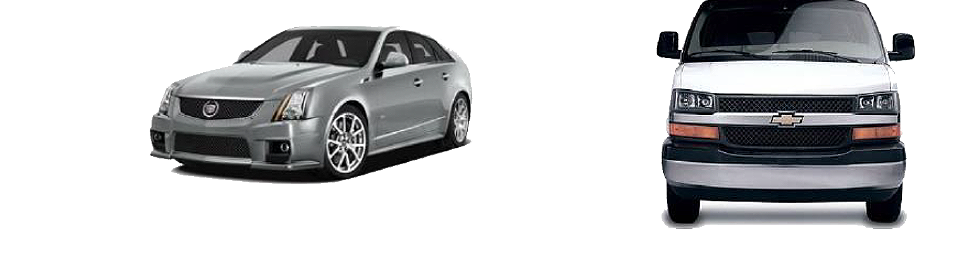
Figure 5. Example of the extracted images.